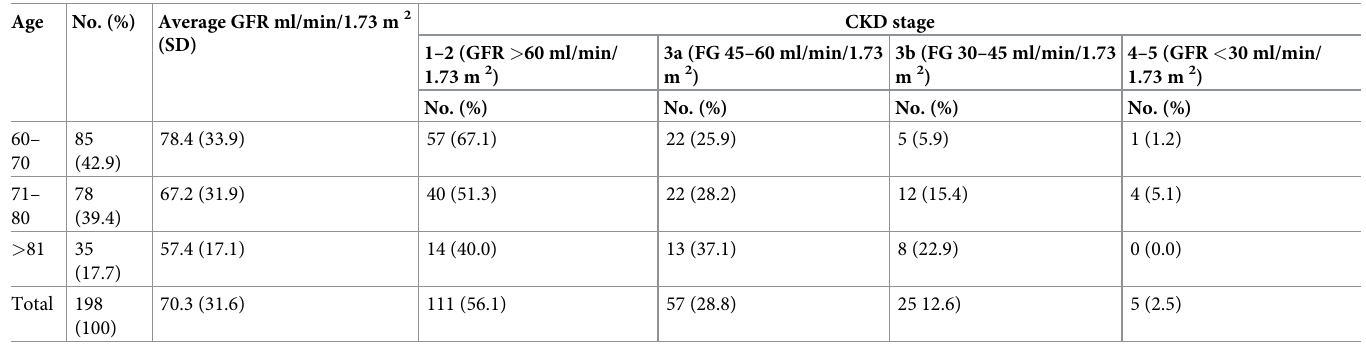
Table 2. Distribution of patients by age group and proportion of patients according to their chronic kidney disease stage.